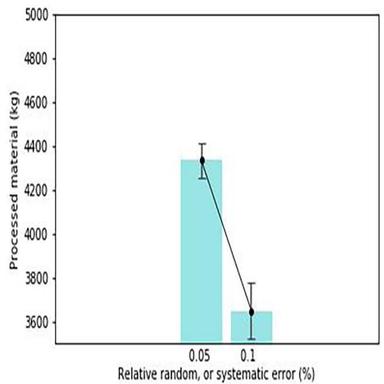
2. A higher number of campaigns went through during the second simulation with the relative random and systematic errors of 0.1% each. The average number of campaigns for the first simulation is 247 ± 3.2, and that for the second simulation is 264 ± 3.5.